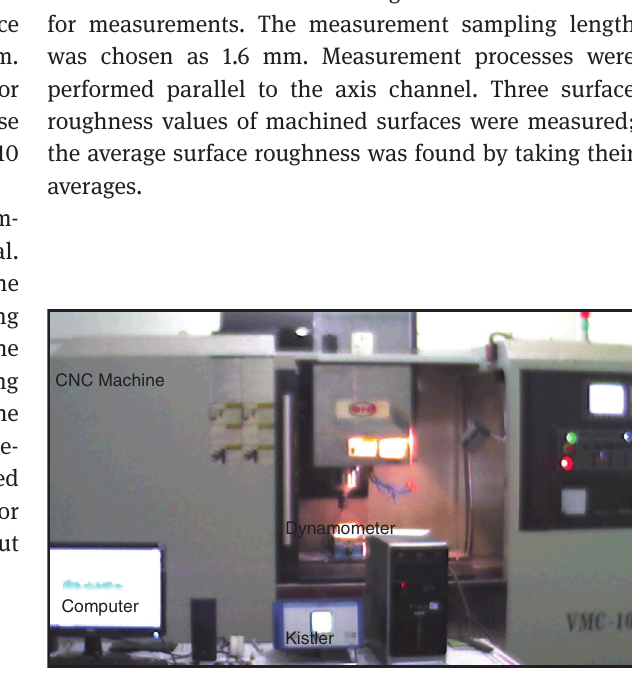
Figure 1 Experimental setup.